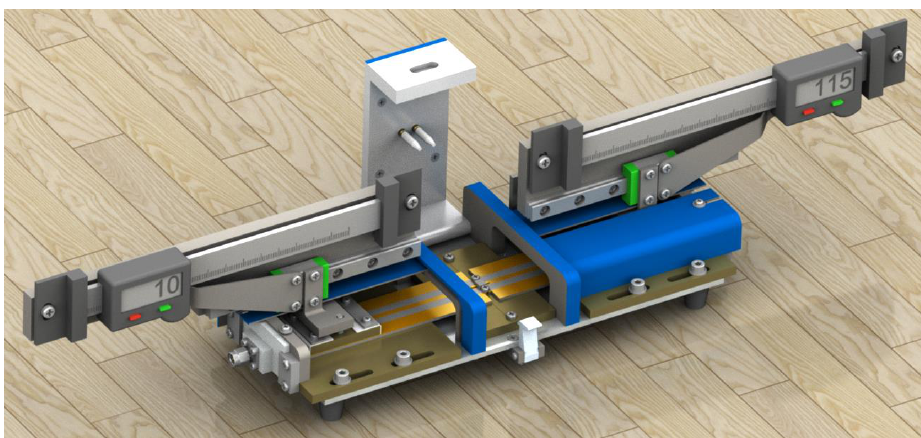
Fig. 5. The appearance of the contact device with tunable matching circuits.